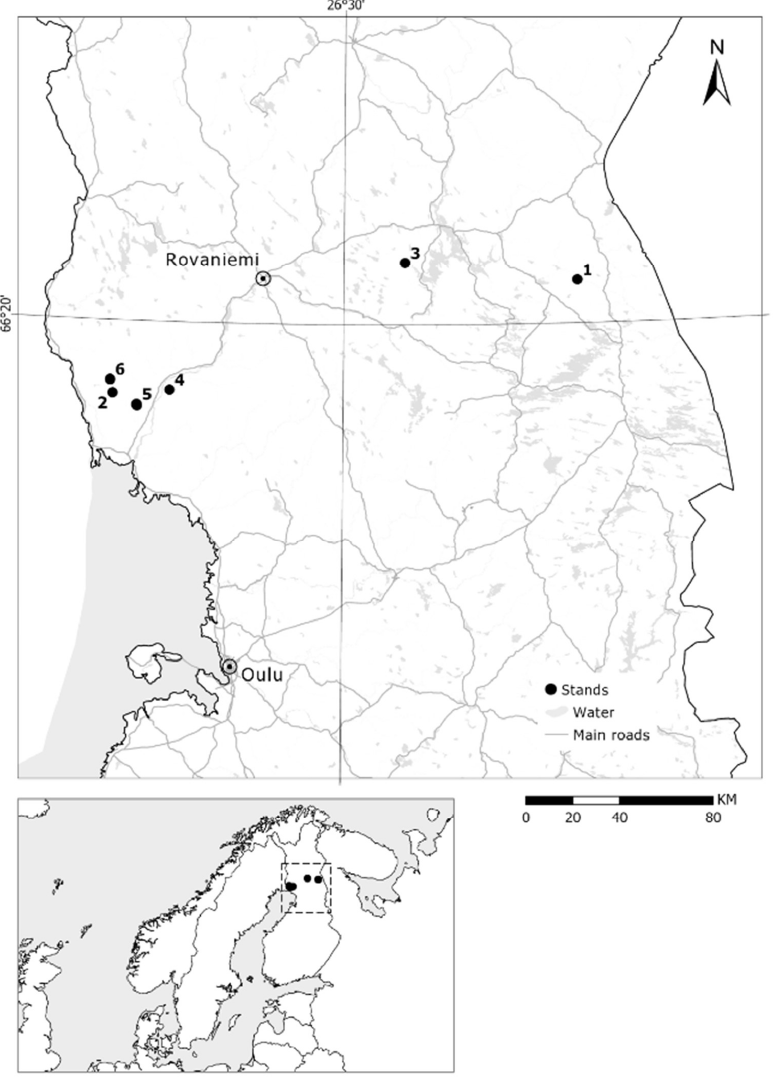
Figure 1. A map presenting the locations of Stands 1–6 under